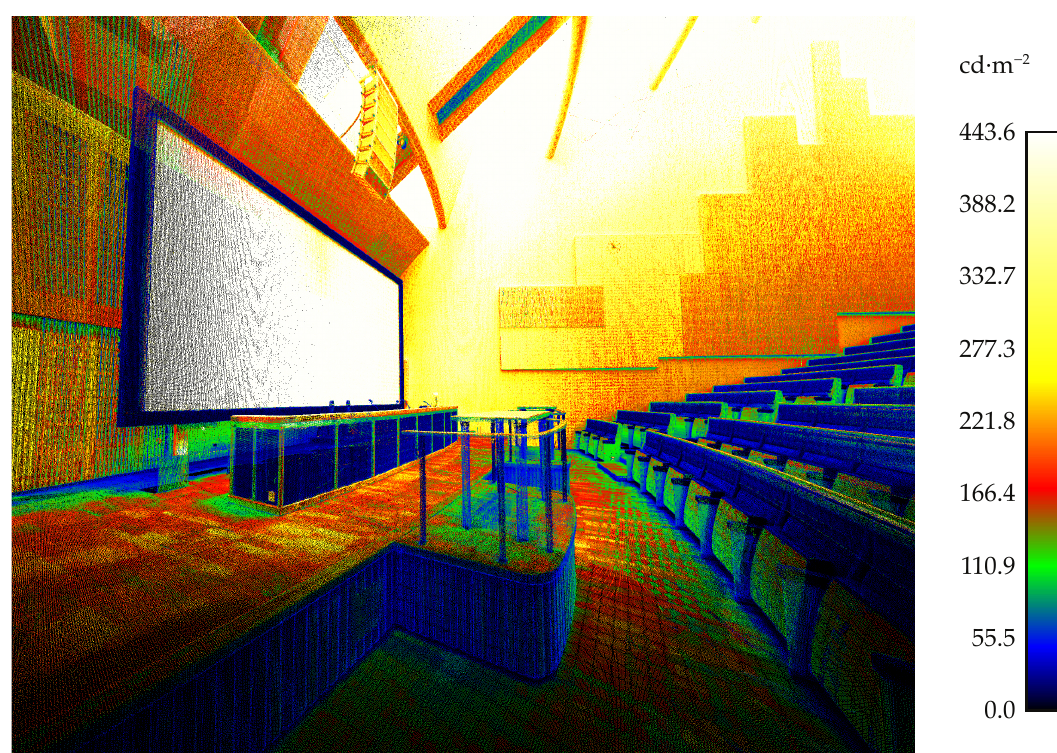
Figure 12. The subsampled luminance point cloud of all scanning